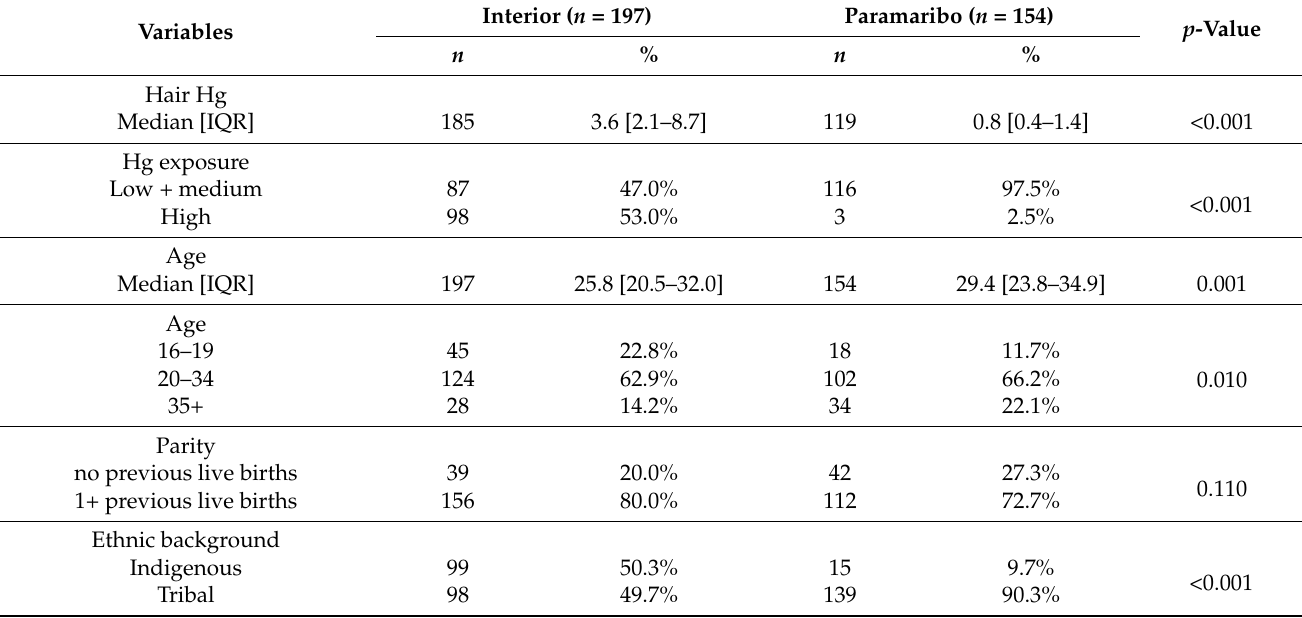
Table 2. Characteristics of participants stratified for geographic